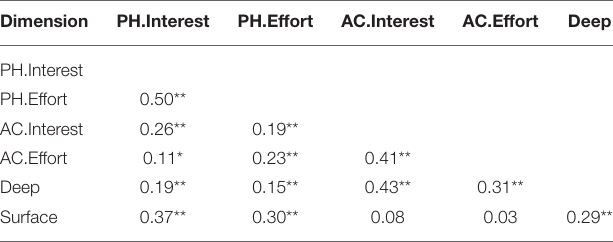
TABLE 5 | Correlation between the dimensions of the PE-Grit scale and the two factors, deep approach, and surface approach.